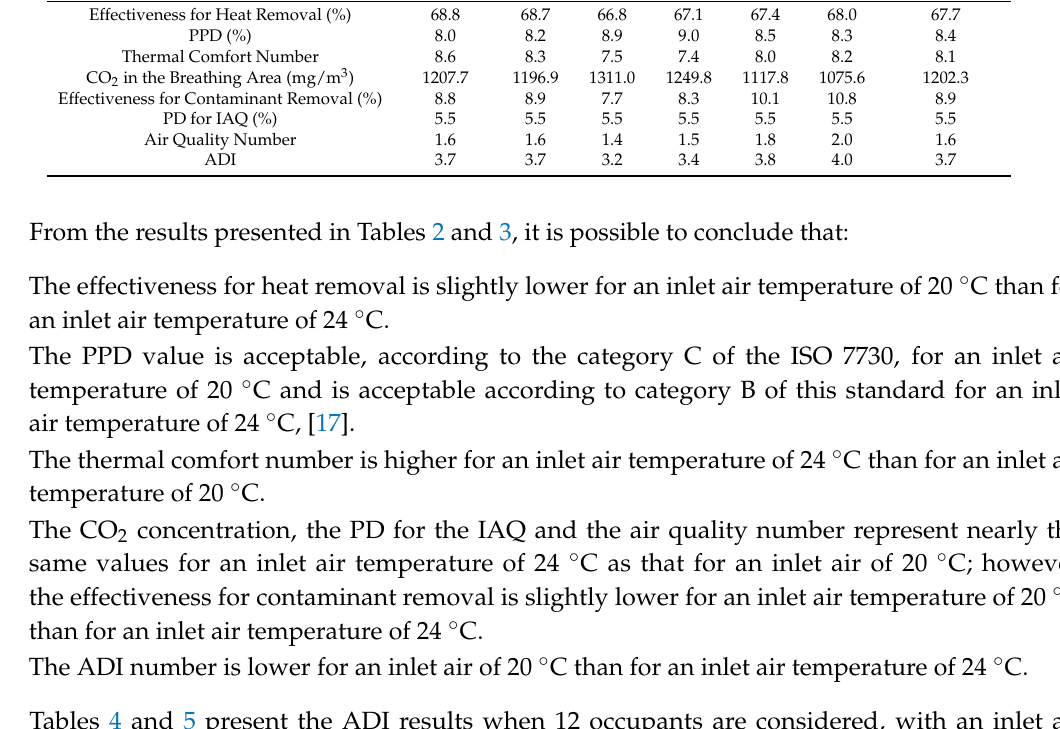
Table 3. ADI for an occupation of 6 persons with an inlet air temperature of 24 ◦ C. Occupants Effectiveness for Heat Removal